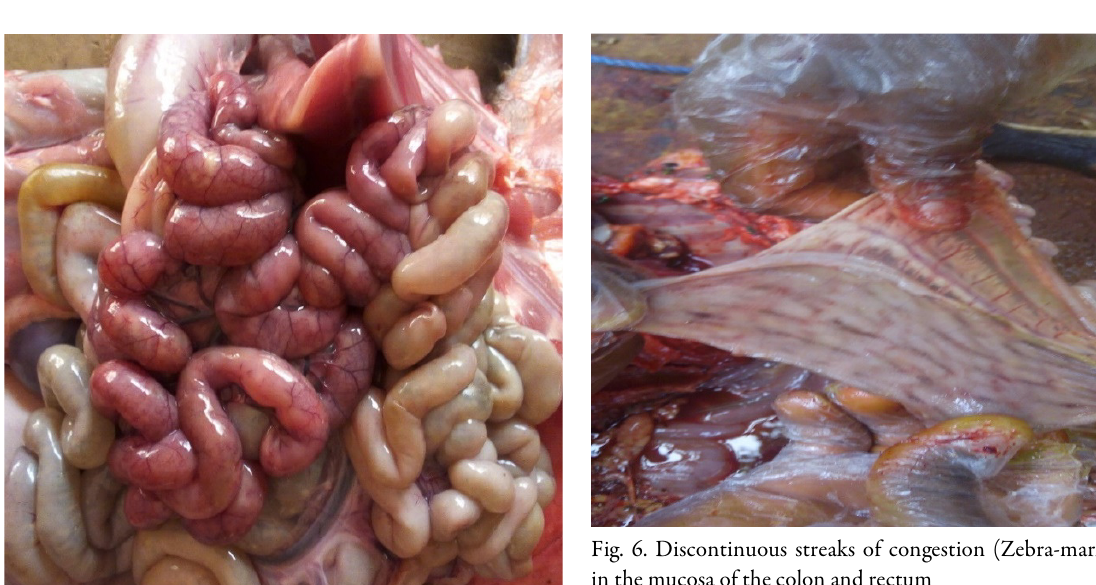
Fig. 3. Diarrhoea observed at the terminal stage of PPR